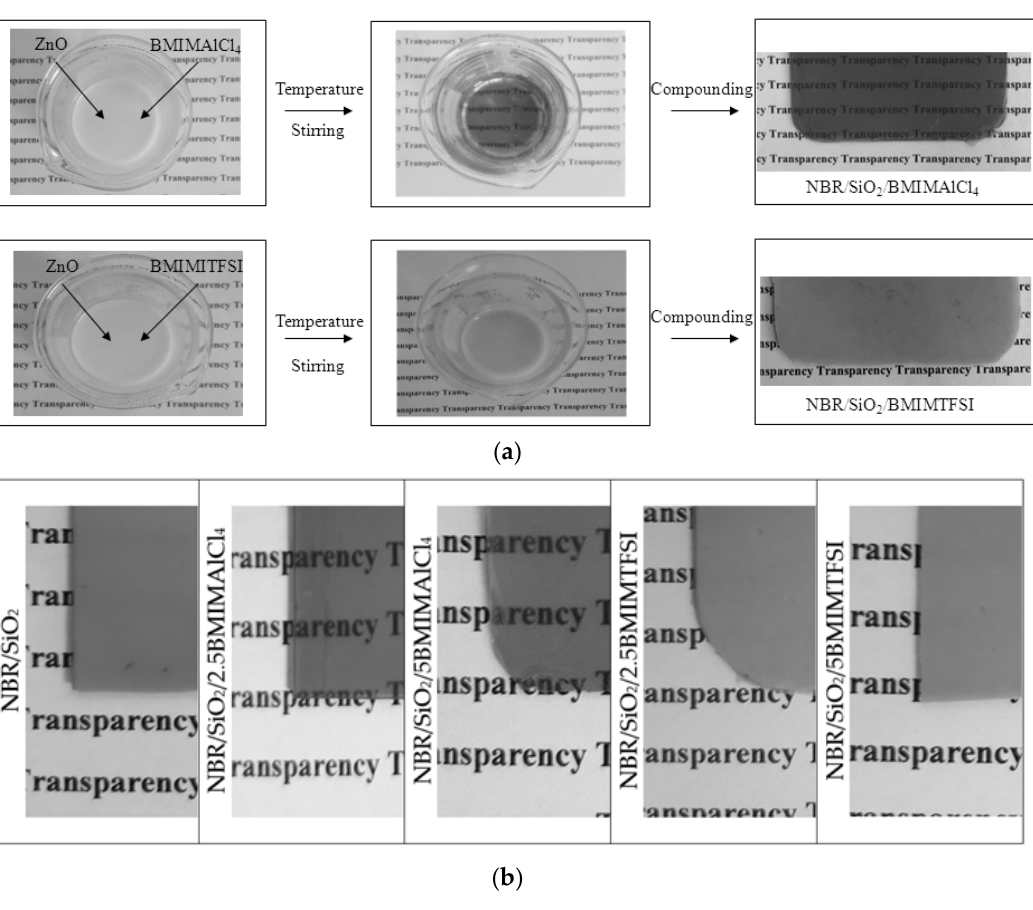
L —lightness; a* —red-green coordinate; b* —blue-yellow coordinate; Δ E —total color change. 3.2. Mechanical Properties, Morphology, Ionic Conductivity, and Thermooxidative Ageing As can be seen in Figure 3a, the presence of the both ILs affected the static-mechanical properties of the silica-filled NBR composites. However, particularly remarkable changes were observed in the case of samples containing IL with AlCl 4 ions. The addition of 2.5 and 5 phr of